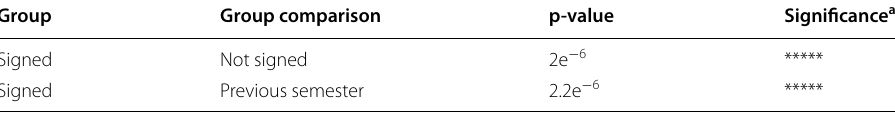
Table 9 Results of the unpaired two‑sample Wilcoxon test on final mark distribution for Markets and behavior